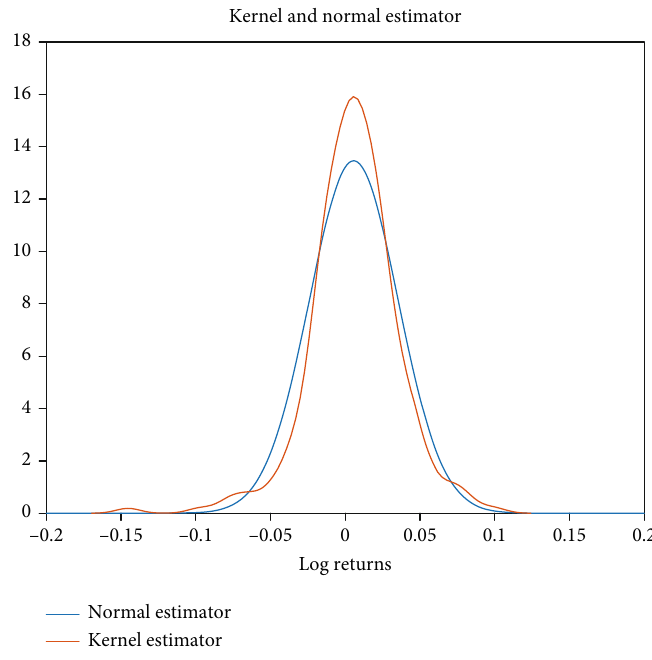
Figure 1: Kernel and normal estimator of Microsoft ’ s log